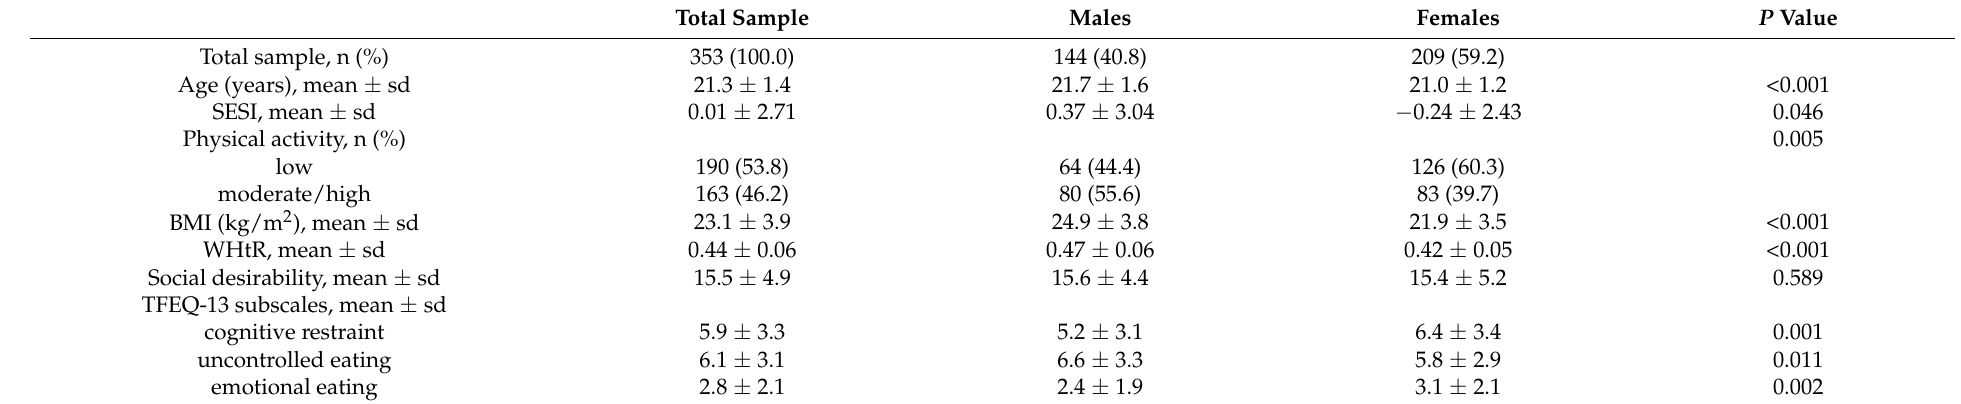
Table 1. Participant characteristics.